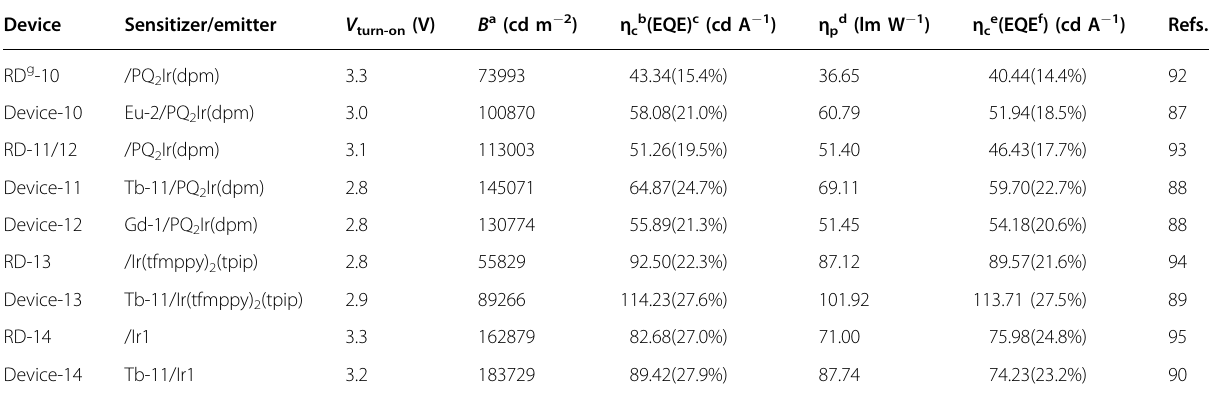
Table 5 The key properties of some representative RE complexes sensitized devices